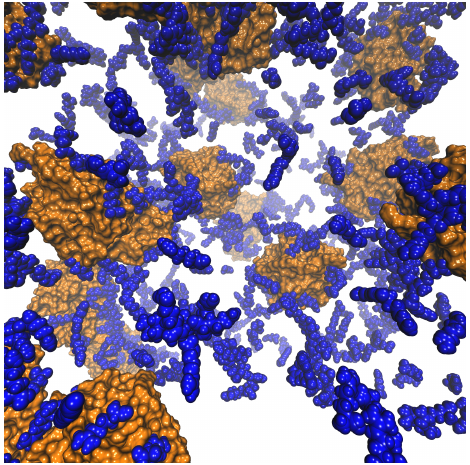
Figure 6. Snapshot of the 93 mg mL − 1 aqueous HEWL solution at 267 K with added 0.3 M arginine. HEWL molecules are represented as orange surface, whereas arginine molecules as blue van der Waals